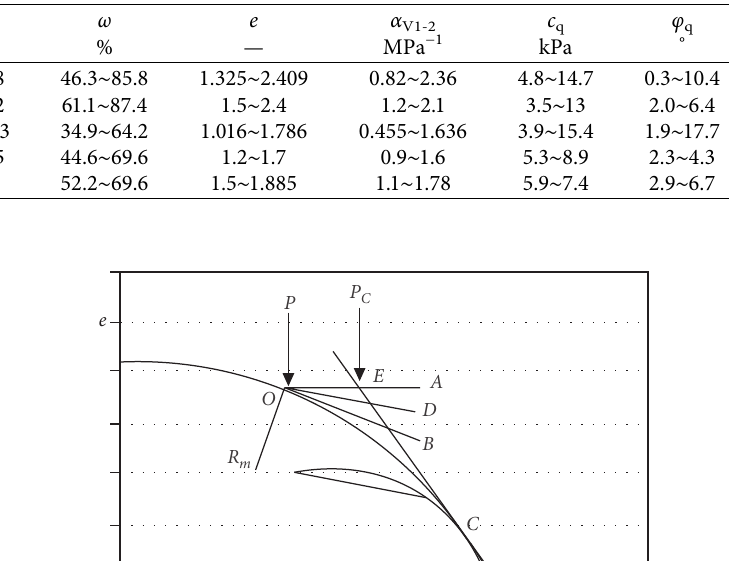
Figure 1: Distribution map of selected soils in the Guangdong-Hong Kong-Macao Greater Bay Area . Table 1: Main physical and mechanical indicators of the samples for each region (mean value).